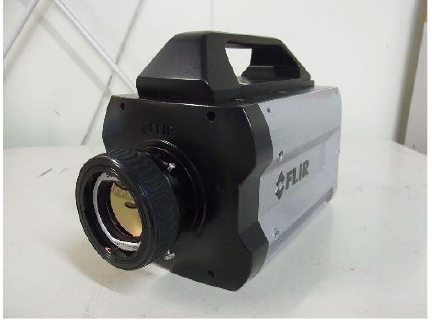
Figure 2. Infrared high-speed camera (FLIR X6900sc).